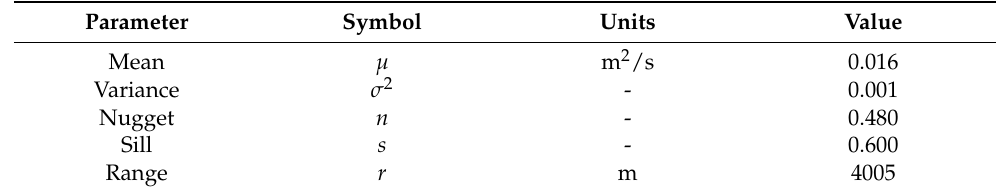
Table 3. Average values of analysed monitoring boreholes during the period of analysis (from 1 May until 31 July 2011).